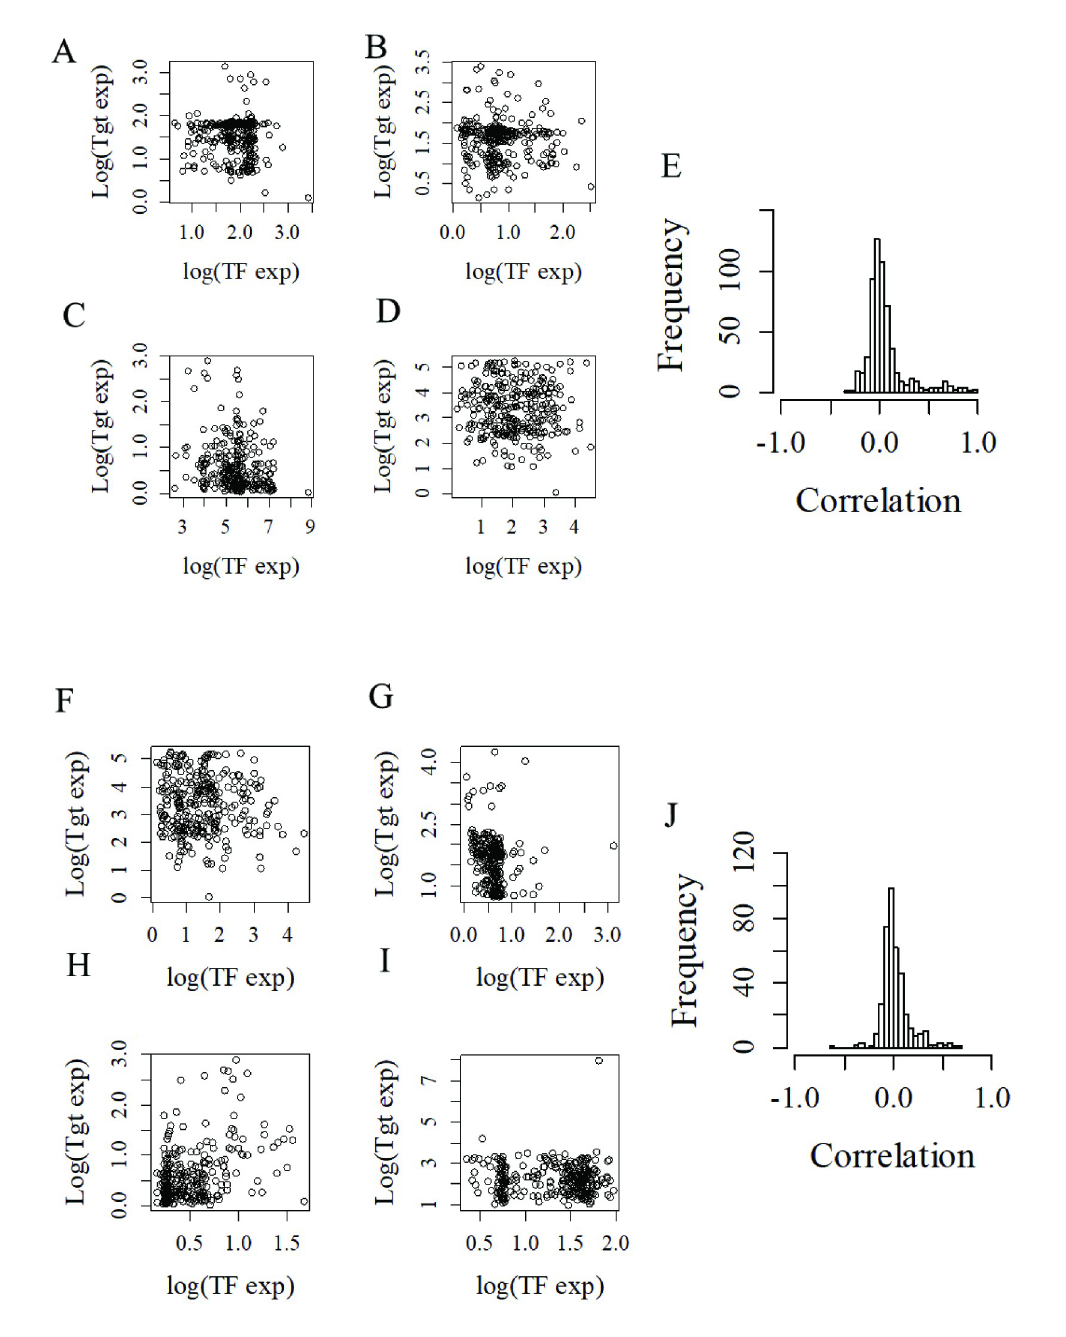
Fig 3. Regulators and direct targets show poorly correlated expression levels in synthetic GRNs. A-D) Typical scatter graphs showing the level of expression of four independent target genes (Tgt, expressed as log-transformed values) as a function of the level of expression of one direct positive regulator (TF). E) Distribution of correlation values of all individual regulator-target pairs involving only positive regulators. F-I) Typical scatter graphs showing the level of expression of four independent target genes as a function of the level of expression of one direct negative regulator (TF). J) Distribution of correlation values of all individual regulator-target pairs involving only negative regulators.